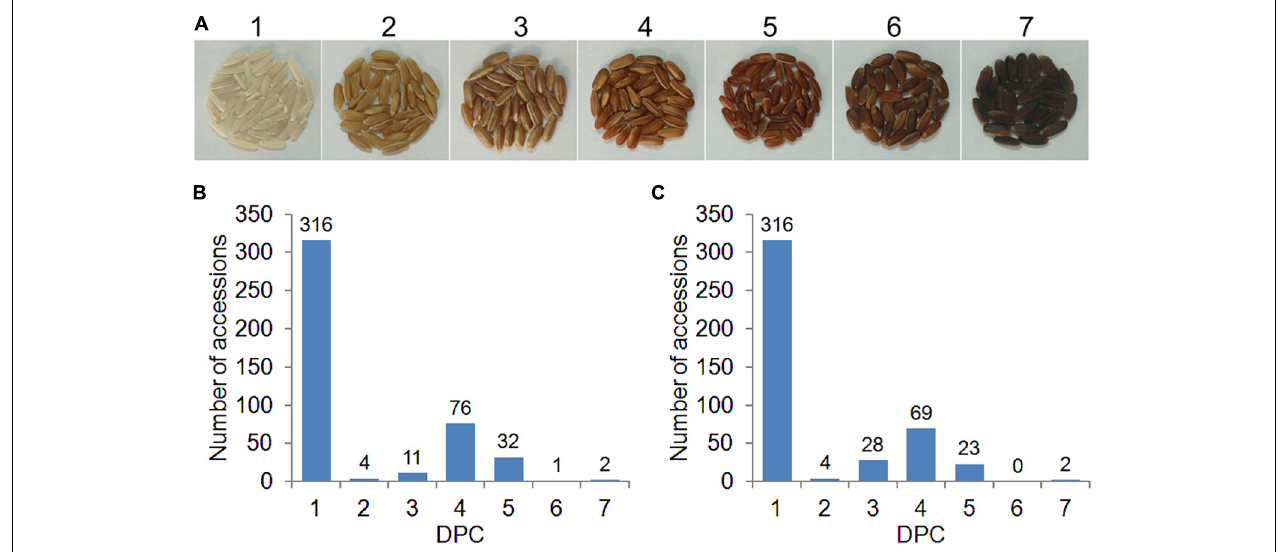
FIGURE 1 | Distribution of pericarp color (PC) in 442 rice accessions. (A) The visual card with scores from 1 (white) to 7 (dark brown) is based on the degree of PC (DPC) from light to dark. (B,C) Distribution of DPC in 2016GZ and 2018YJ, respectively.